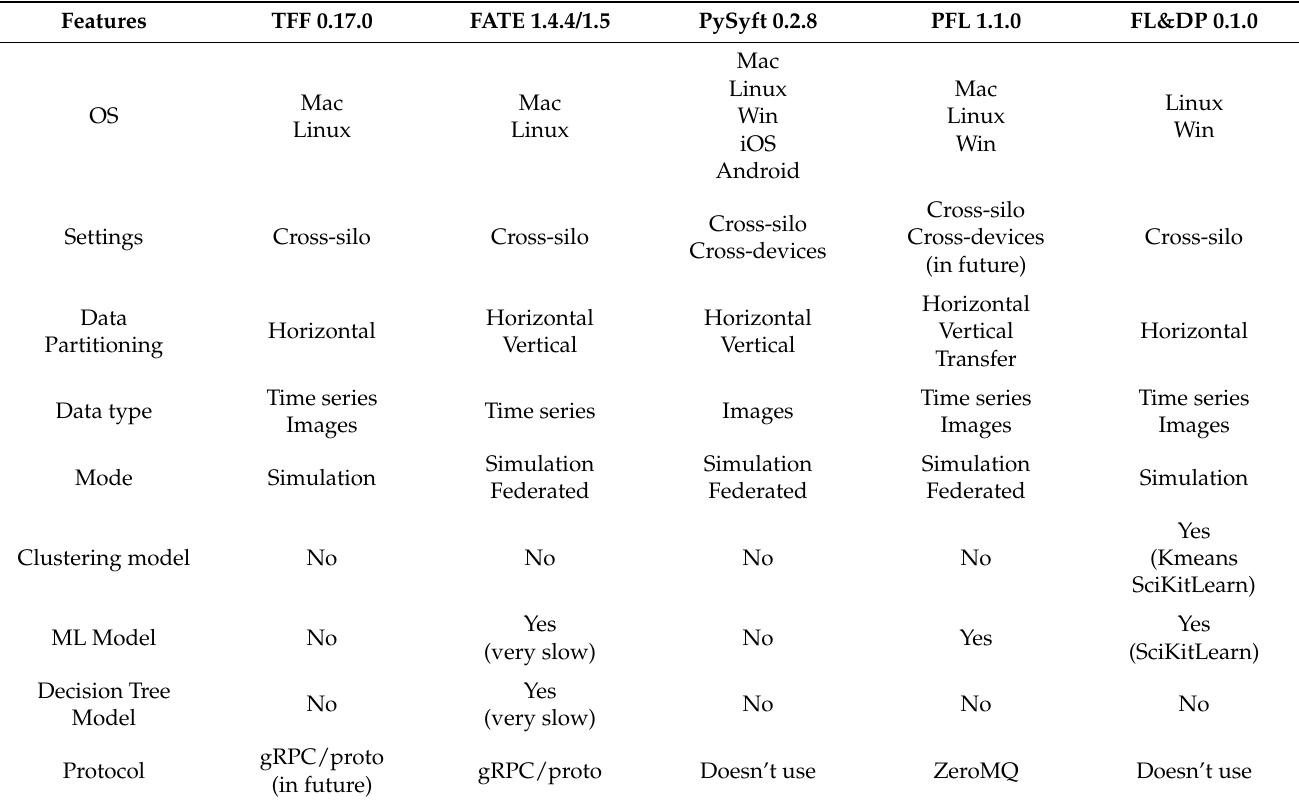
Table 3. Comparison of the open-source federated learning systems’ (FLSs’)